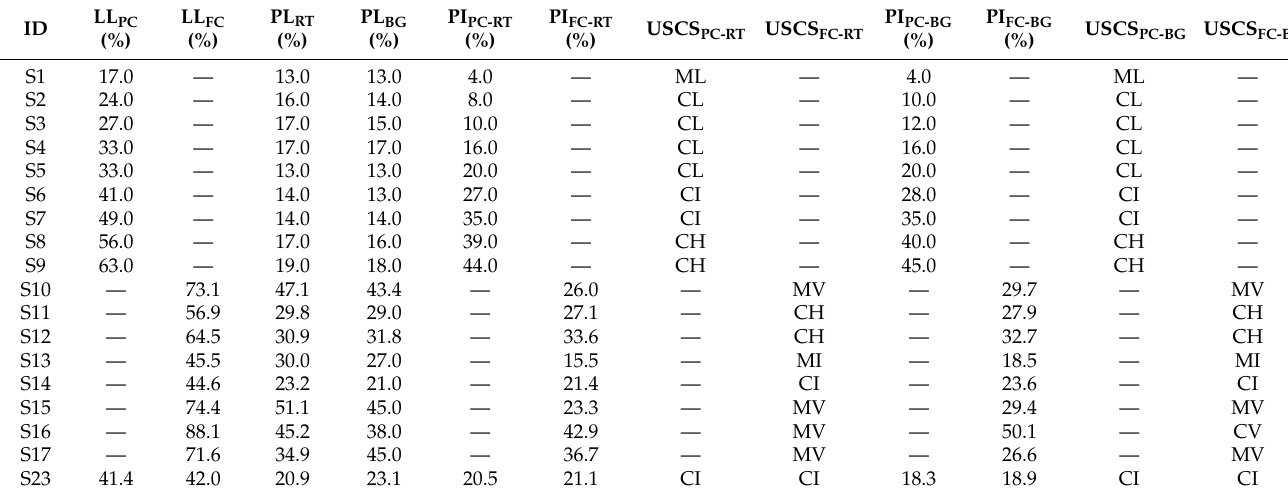
Table 2. Summary of the soil classification results employing PL RT and PL BG for the compiled database (excluding S18–S22 for which the LL PC or LL FC values were not